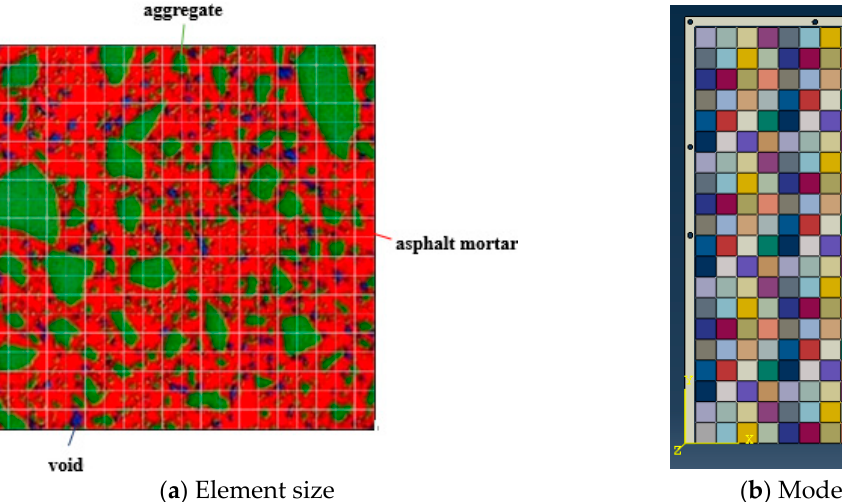
Figure 3. Schematic diagram of FEM model based on homogenization method.